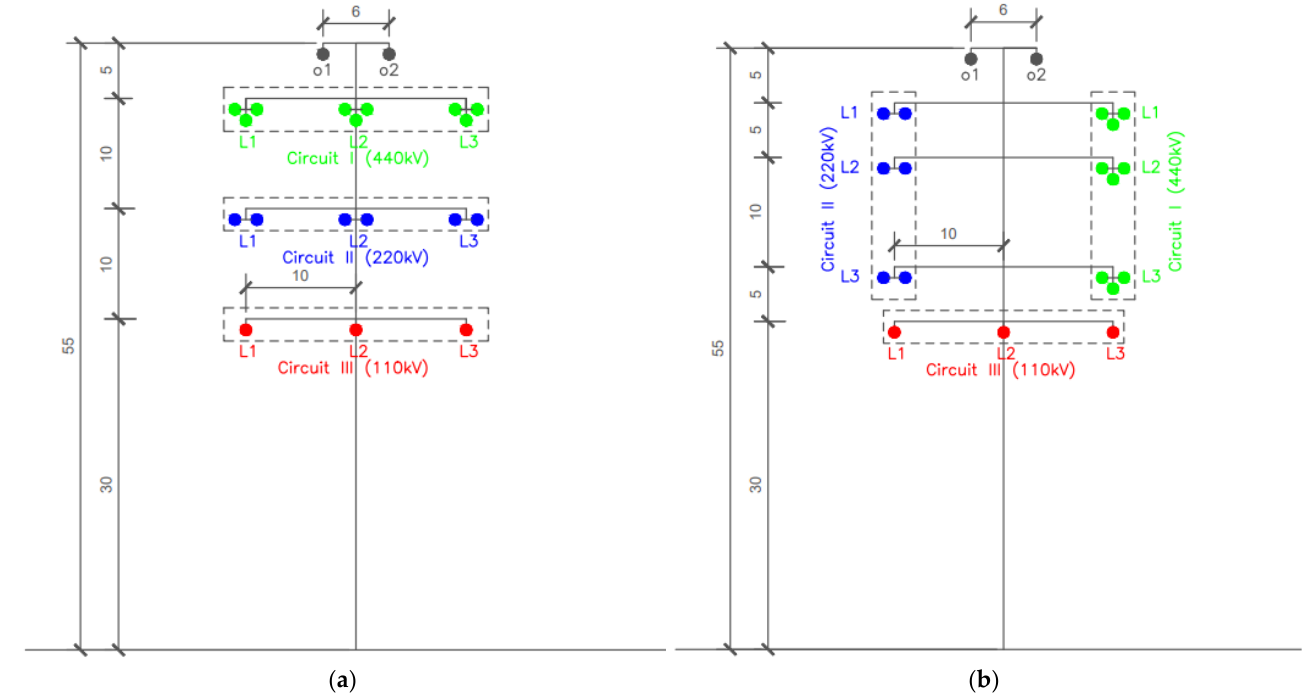
Figure 4. The possible arrangement of the conductors in the line: ( a ) a horizontal of the phase conductor configuration of transmission line; ( b ) vertical and horizontal of the phase conductor configuration of transmission line.